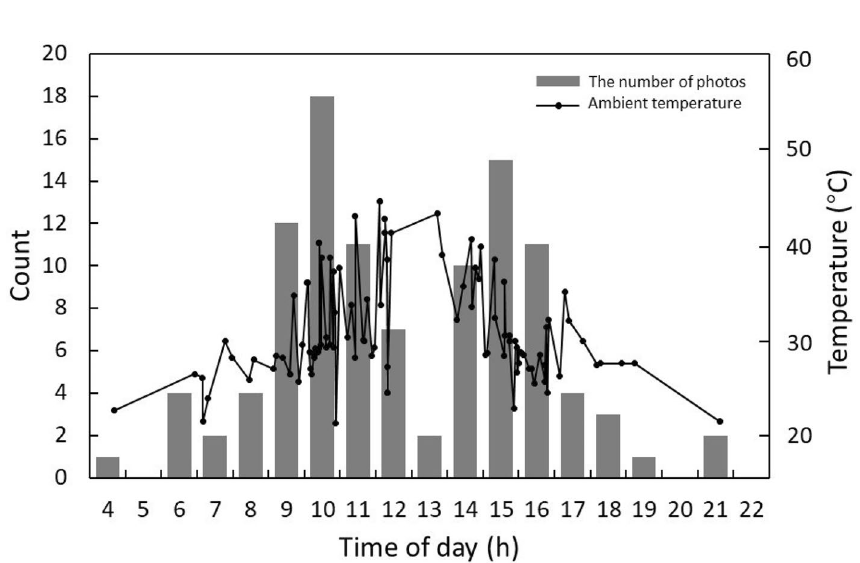
Figure 3. Relationship between substrate surface temperature (°C, solid line), shelter inside temperature (°C, long dotted line) and body surface temperature ( ◦ C, short dotted line) from 16 E. dione during study period (1st May–25th July 2021). Light grey short dotted line represents no data collected during the period. Mean ± S.E. for each hour of the day is shown.